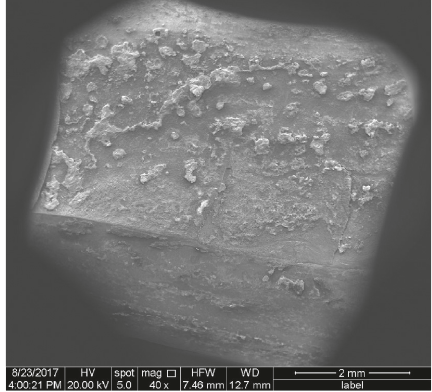
Figure 7: Micromorphology of fracture extended area.